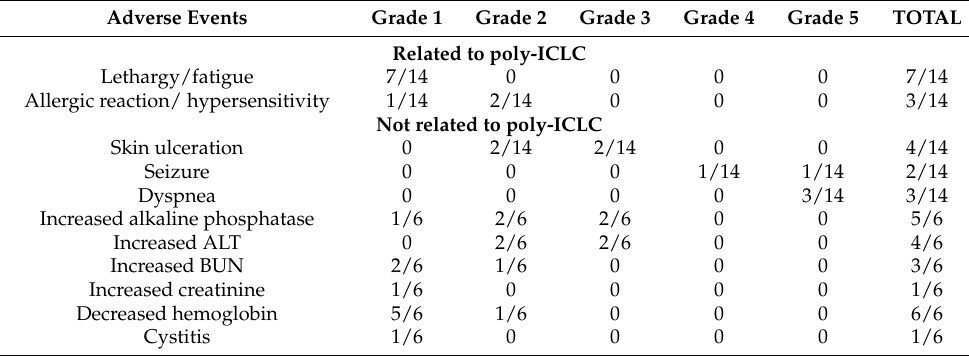
Table 4. Adverse events related and not related to poly-ICLC